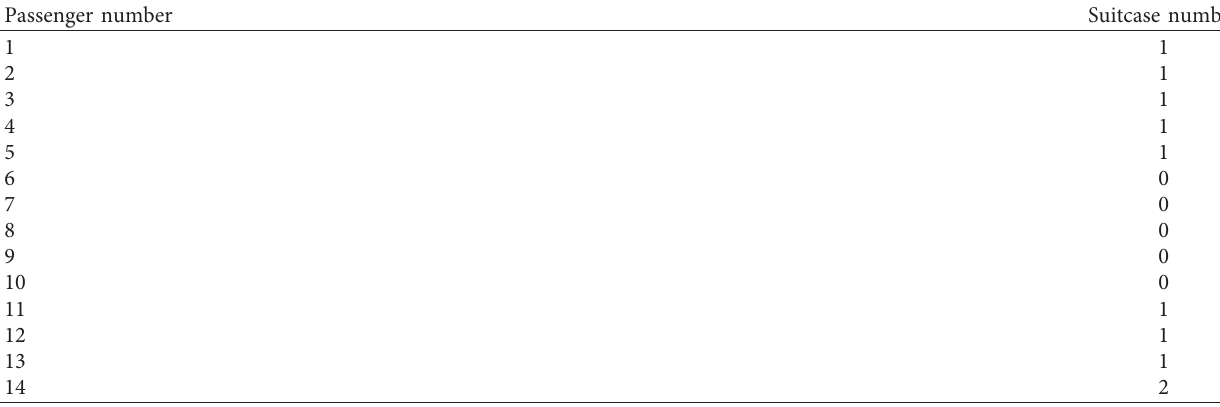
Figure 9: Queuing area before security check used for simulation. Table 3: Collection of passengers’ suitcase numbers.